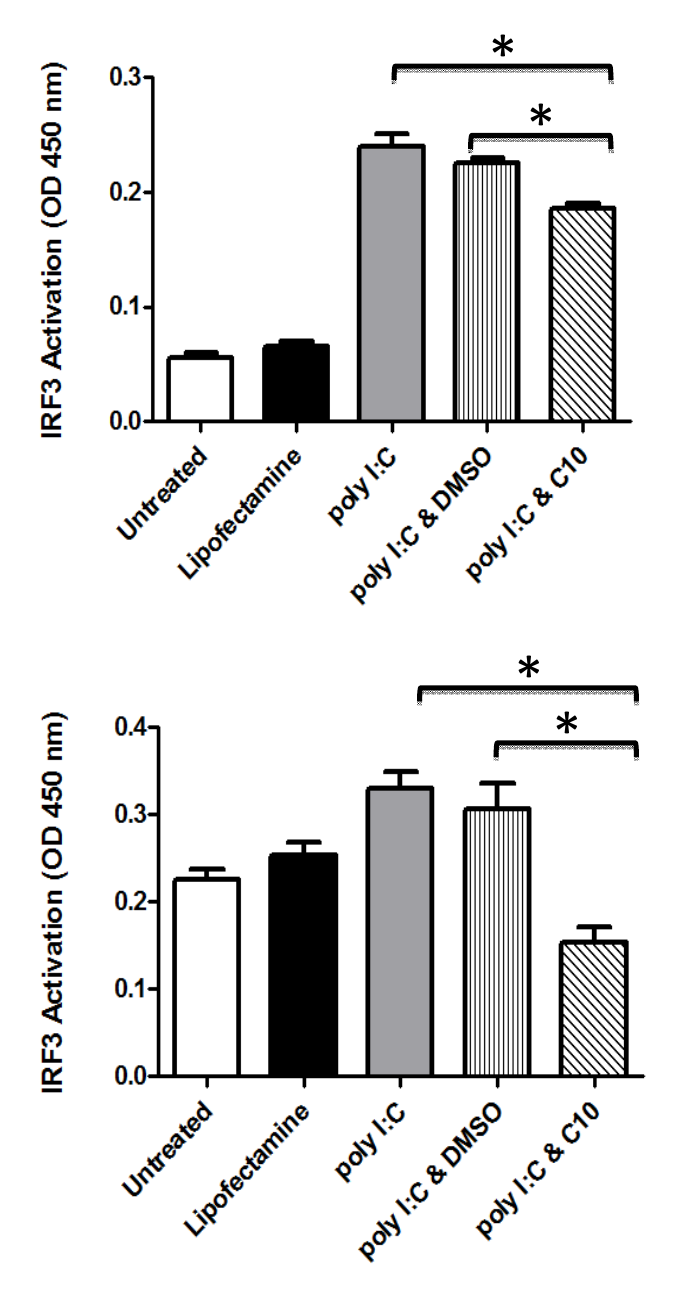
Figure 1. C10 inhibits IRF3 activation in human cell lines. 293-hTLR3-HA ( A ) and PANC-1 ( B ) cells were stimulated with 100 μ g/mL Poly I:C during 6 h in the presence or absence of C10 or vehicle (DMSO). IRF3 binding activity in nuclear extracts (5 μ g or 10 μ g protein respectively) was determined using an ELISA-based technique. Results are presented as mean ± SD from 3 biological replicates. Significance was determined using one-way ANOVA followed by Tukey’s multiple comparison test. * p < 0.05 between groups as indicated. All poly I:C treatment groups were statistically different than untreated and lipofectamine control groups, p <